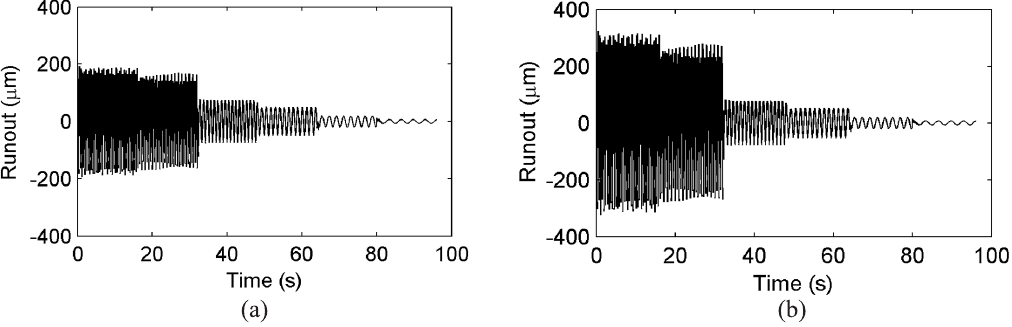
Fig. 6. Response of the simulation at UGB direction X, (a) Our model and (b) A constant coefficients